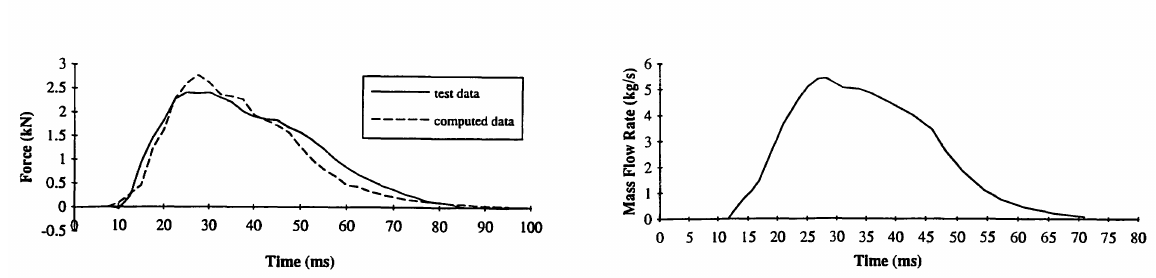
FIGURE 8 Comparison of computed and measured force on drum for aspirated system.